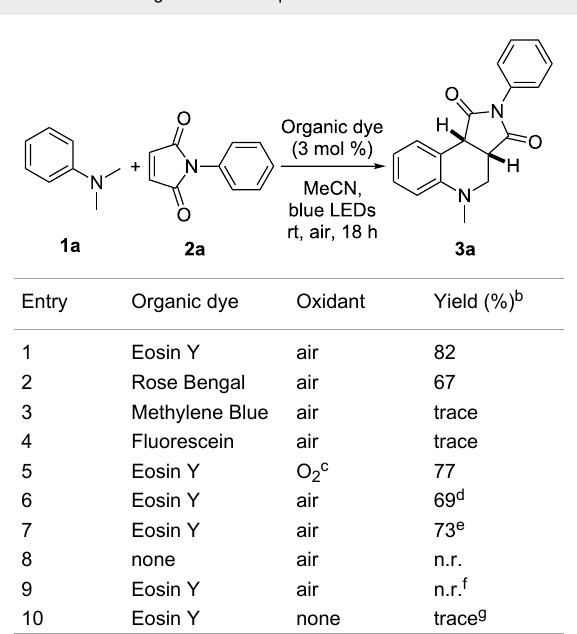
Table 1: Screening and control experiments a